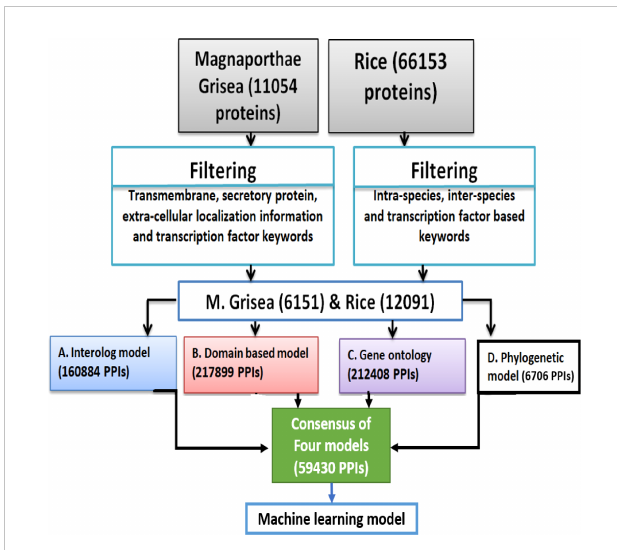
FIGURE 1 A schematic representation showing the overall prediction network for the proposed model development.